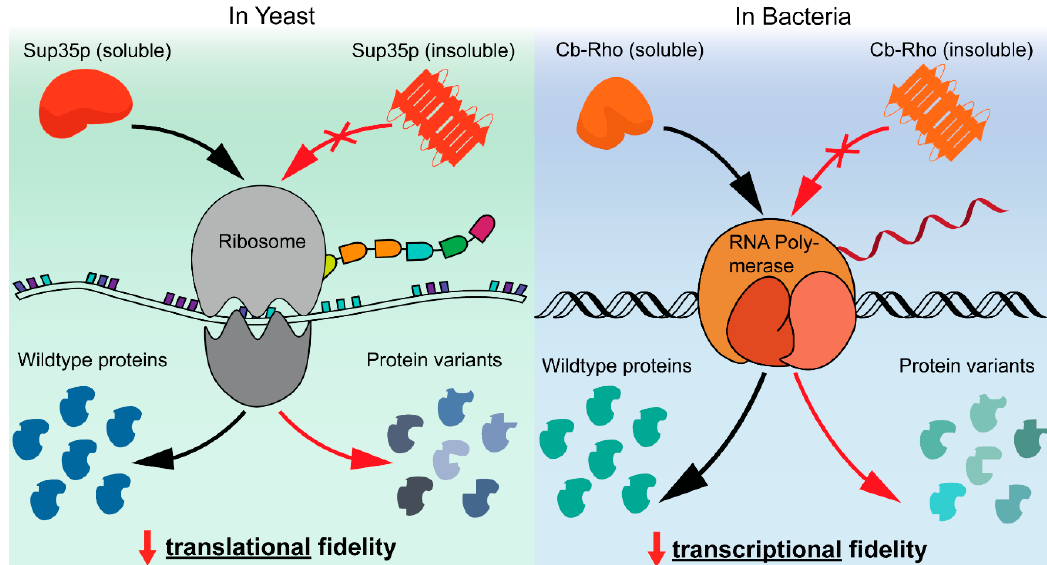
Figure 4. The insoluble amyloid forms of Sup35p and Cb-Rho allow the creation of protein variants better suited to survive in sudden environmental fluctuations. In yeast, the loss of an active translation termination factor Sup35p leads to a stop codon read-through, giving rise to new phenotypes. In bacteria, the same result is accomplished through the loss of the transcriptional terminator factor Rho and, thereby, a decrease in transcriptional fidelity.